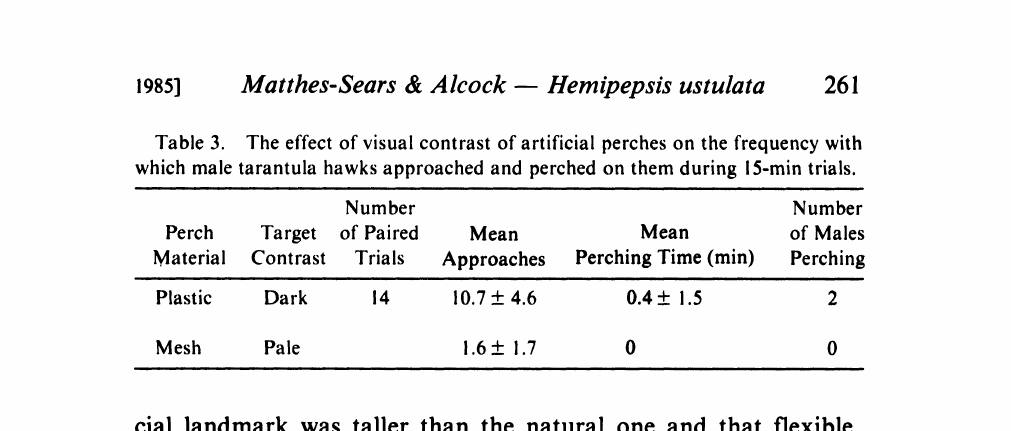
Table 3. The effect of visual contrast of artificial perches on the frequency with which male tarantula hawks approached and perched on them during 15-min trials. Number Number Perch Target of Paired Mean Mean of Males Material Contrast Trials Approaches Perching Time (min) Perching